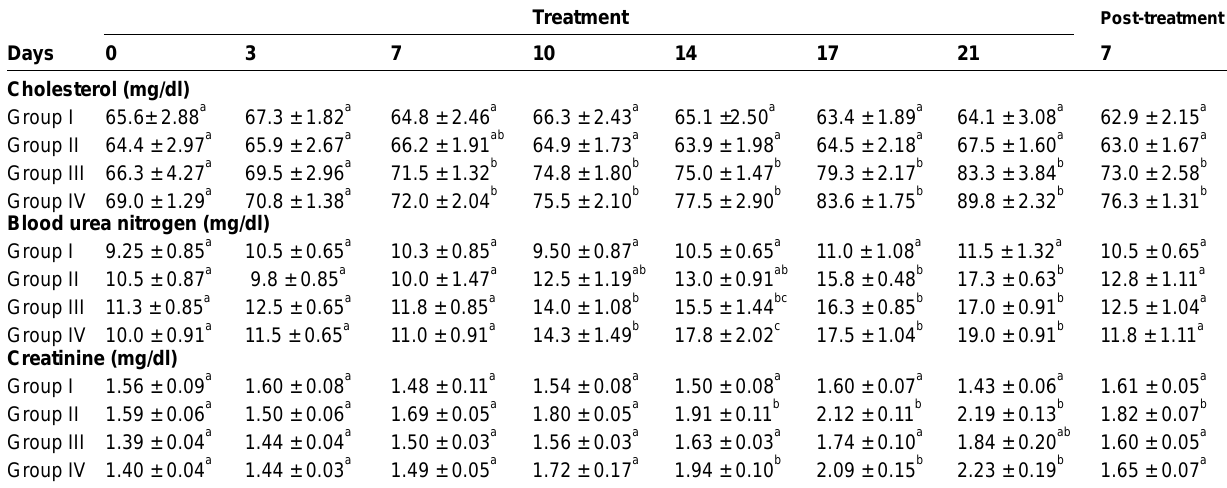
Values given are mean ± SE, n= 4*, *Means with at least one common superscript do not differ significantly (p<0.05). Group I - Control, II - Fenvalerate, III - Sodium nitrate, IV - Fenvalerate and Sodium nitrate